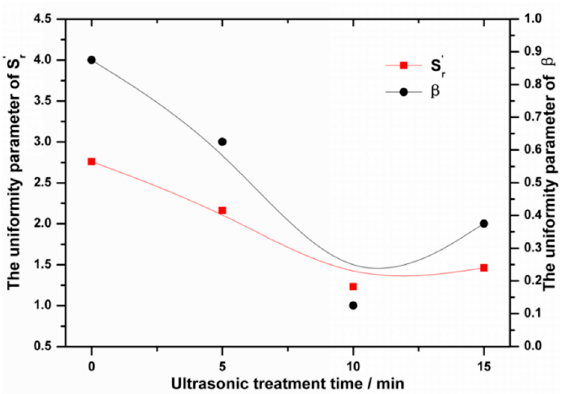
' S and β under different ultrasonic treatment times. r S and β under different ultrasonic treatment times. r